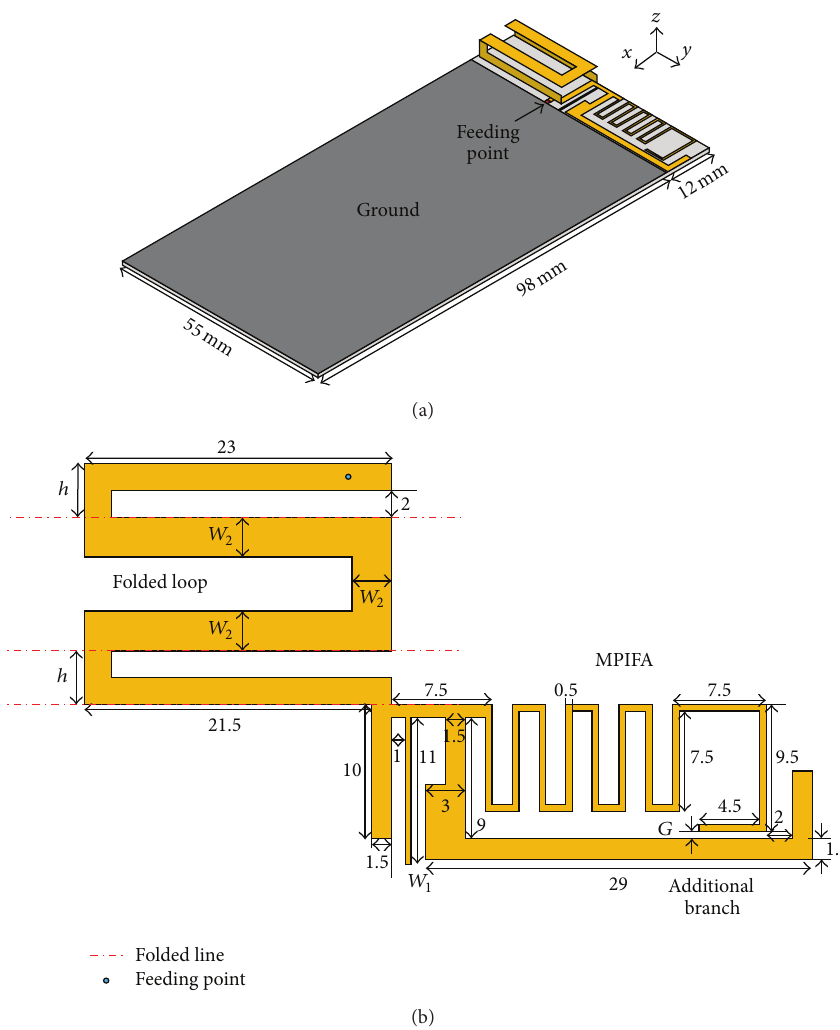
Figure 1: Configuration of the proposed antenna. (a) Overview. (b)